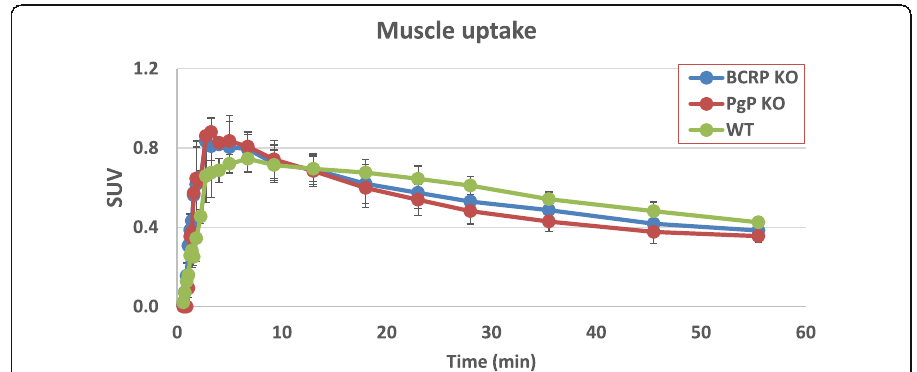
Fig. 10 Muscle time activity curves of [ 18 F] 5 in P-gp KO mice (red squares), BCRP KO mice (blue diamonds) and WT mice (green